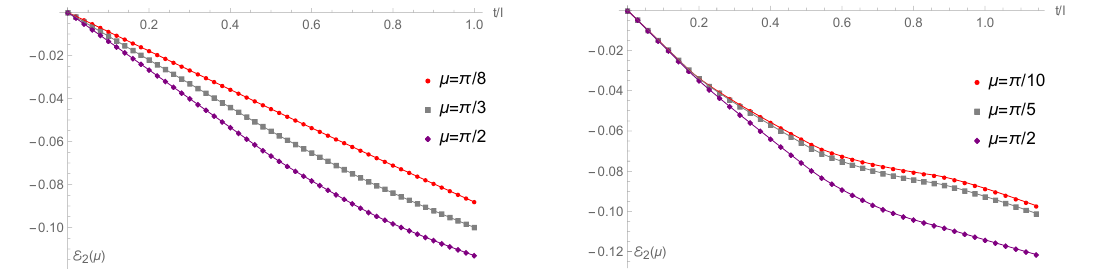
Figure 3 . Charged Rényi logarithmic negativity E 2 ( µ ) as a function of t/l for different µ after the mass quench from m 0 = 1 to m = 2 in the complex harmonic chain. The full lines are the quasi-particle predictions (cf. eq. (7.10) and eq. (7.13)). Left panel: adjacent intervals with L = 2500 , l 1 = 200 , l 2 = 300 and for µ = π 2500 , l 1 = 150 , l 2 = 200 , d = 50 and for µ = π extremely excellent.